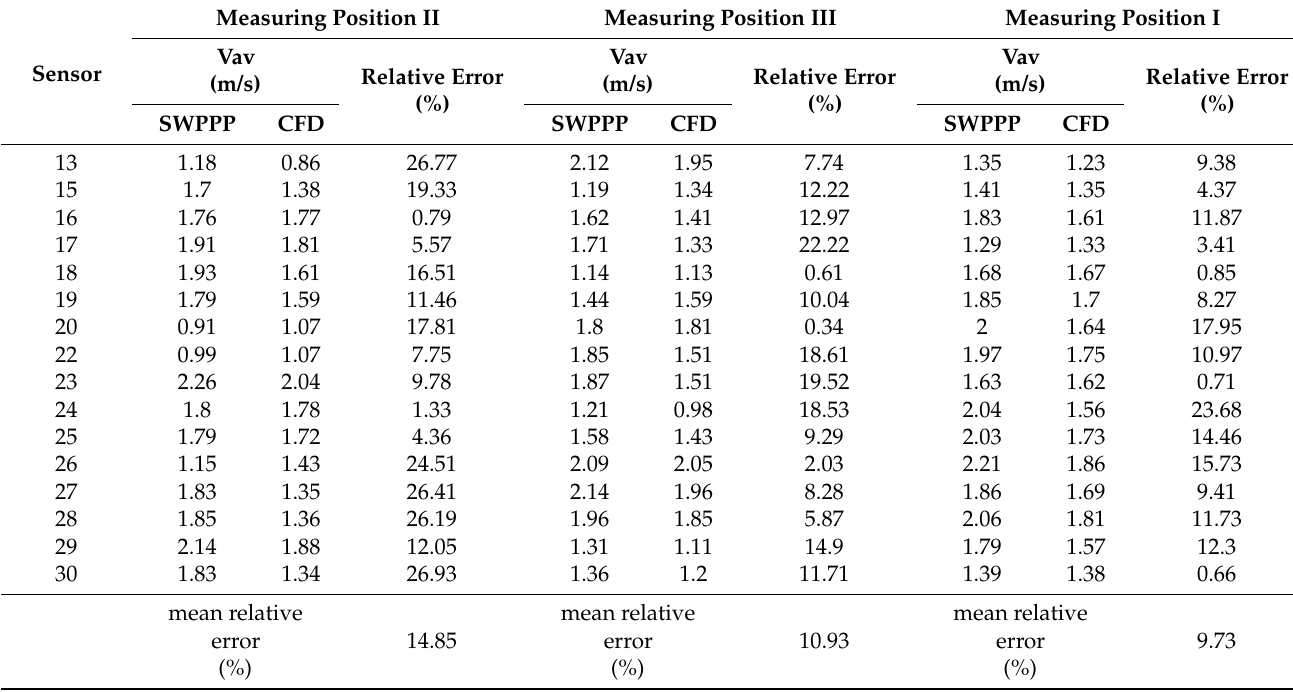
Figure 8. Velocity profile obtained by linear interpolation of the experimental data from Position II. Table 2. Comparison of numerical computation results with the results of measurements for measuring positions together with the calculated relative